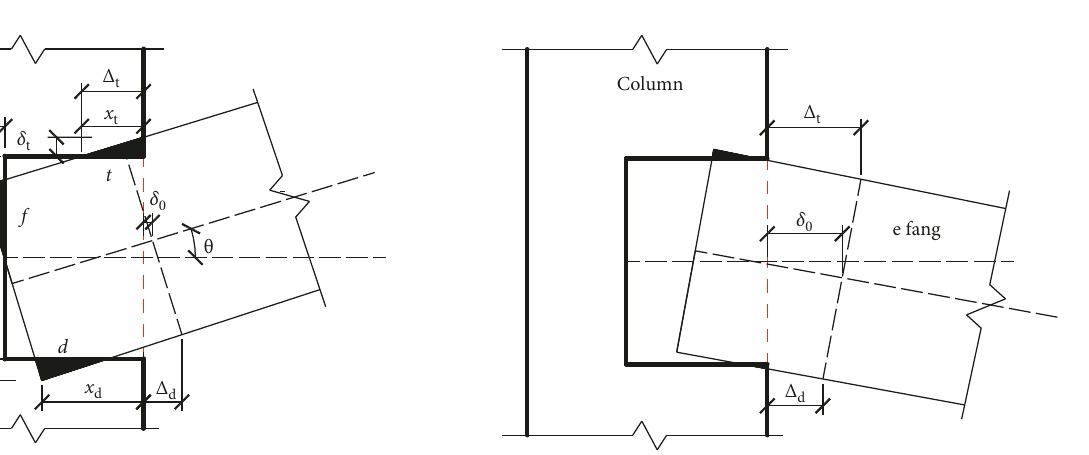
Figure 5: Tenon deflection under downward